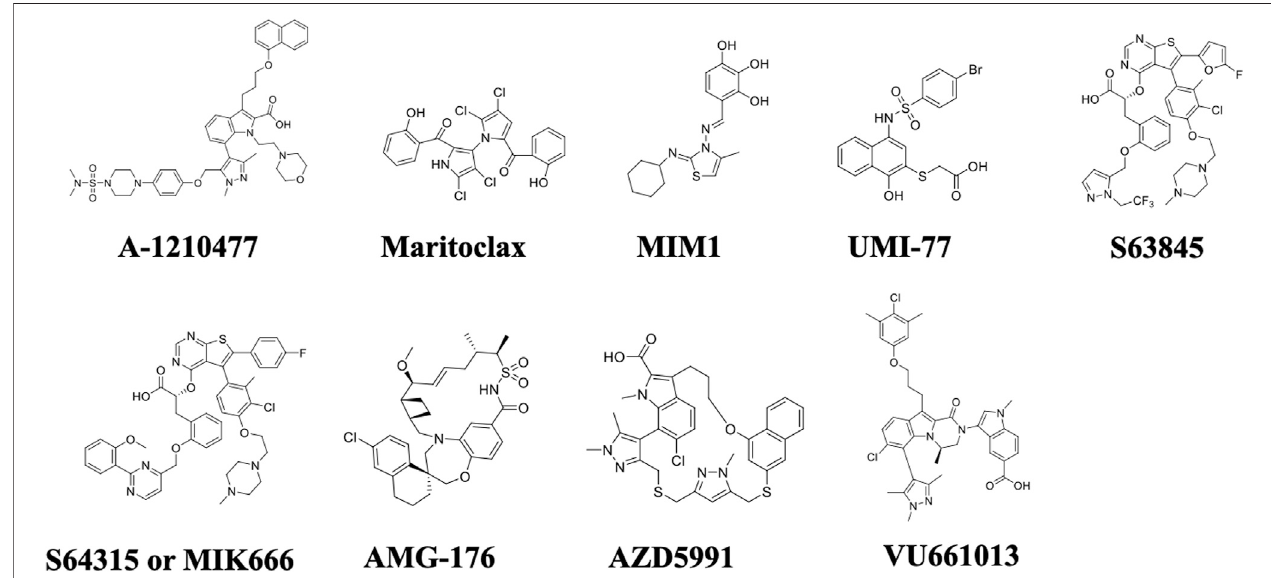
FIGURE 4 | Chemical structures of selective Mcl-1 inhibitors. The most prominent Mcl-1 inhibitors including A-1210477, Maritoclax, MIM1, UMI-77, S63845, S64315/MIK666, AMG-176, AZD5991, and VU661013.